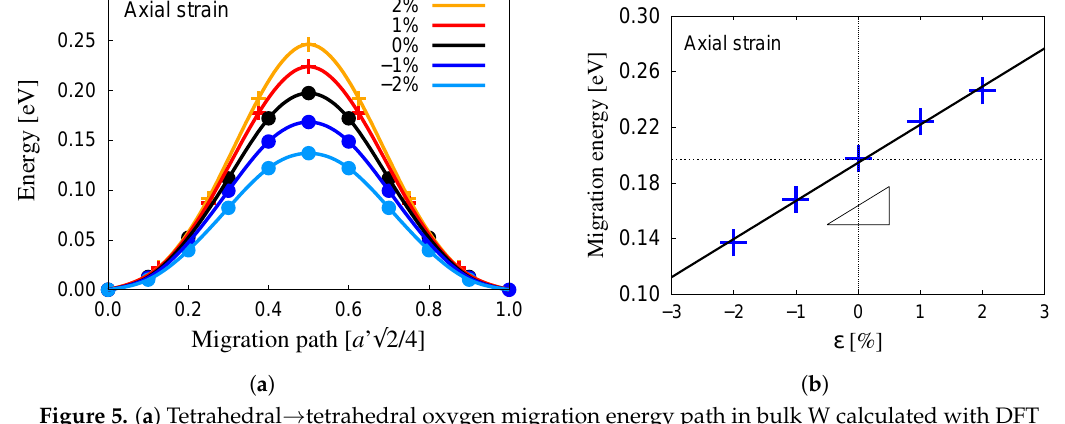
Figure 5. ( a ) Tetrahedral → tetrahedral oxygen migration energy path in bulk W calculated with DFT between two neighboring tetrahedral sites under hydrostatic strain. a (cid:48) is defined in Equation (1). ( b ) Migration energy barrier under uniform axial strain. The black line represents a least-squares linear fit, from whose slope (black triangle) the activation volume can be calculated.